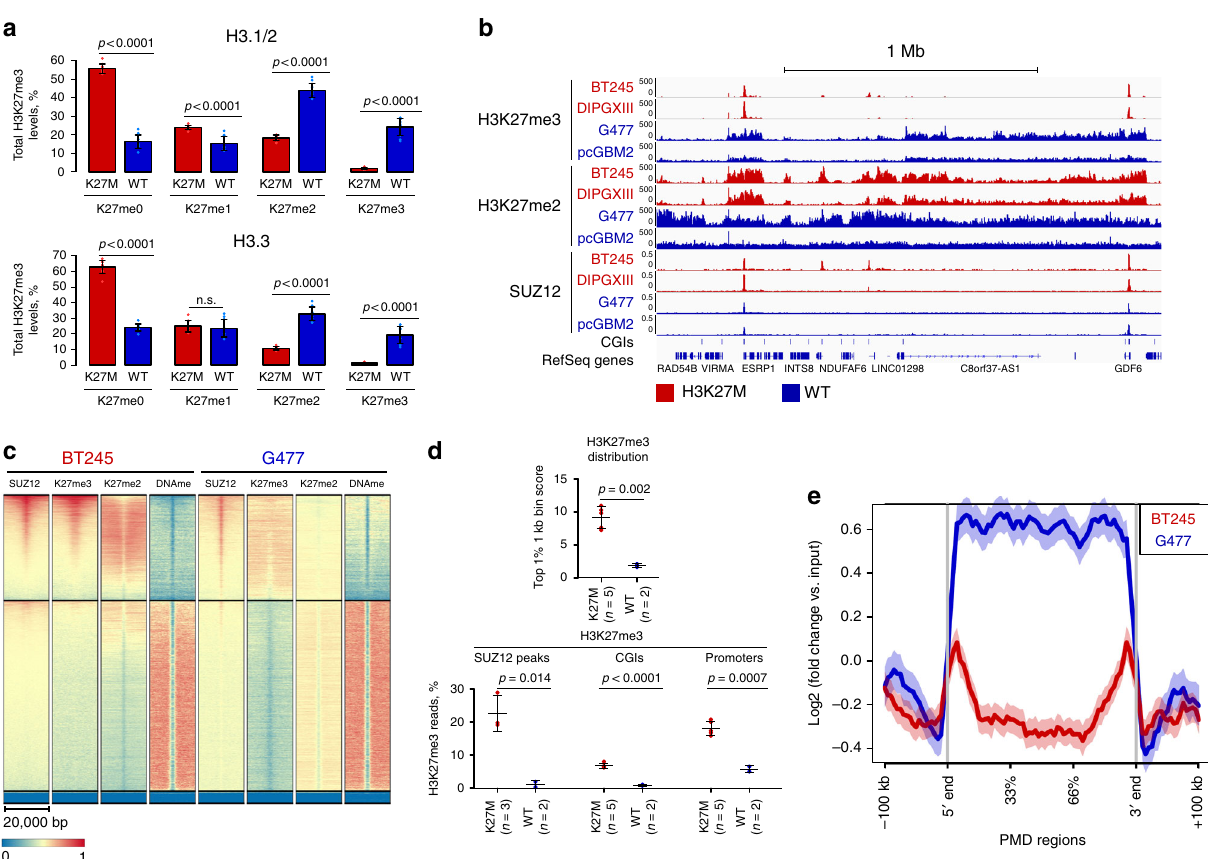
Fig. 1 H3K27M-mutant pediatric high-grade gliomas (pHGGs) exhibit distinct distribution of H3K27me3 and H3K27me2 a H3K27me1/2/3 abundance quanti fi ed by mass spectrometry, primary cells (WT n = 3 cell lines, K27M n = 3 cell lines, three replicates for each cell line, mean ± standard deviation, Student ’ s t -test). b Example of normalized H3K27me3 and H3K27me2 chromatin immunoprecipitation sequencing (ChIP-seq) tracks of H3K27M and WT pHGG lines, showing qualitative differences in distribution of these marks. For comparison, SUZ12 ChIP-seq tracks, and CpG islands (CGIs) are shown. c Heatmap plots of ChIP-seq signal intensity for SUZ12, H3K27me2/3, and DNA methylation (whole-genome bisulphite sequencing (WGBS)) over CGIs for BT245 (H3K27M) and G477 (WT). CGIs are separated by kmeans clustering ( k = 3). d Top: Average enrichment at the top 1% of 1 kb bins for H3K27me3. Bottom: Proportion of H3K27me3 reads in SUZ12 peaks, CGIs, promoters. H3K27M cells show higher enrichment for H3K27me3 in top 1% 1 partially methylated domain (PMD) regions in BT245 (H3K27M) and G477 (WT) cells, aggregate plot. Source data are provided as a Source Data fi